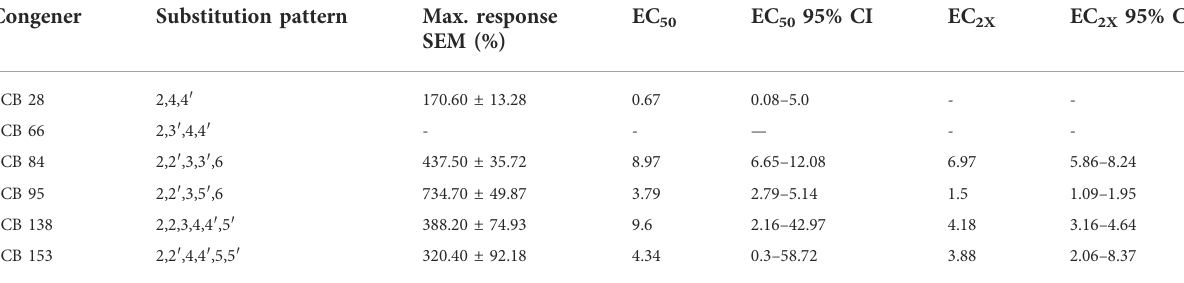
TABLE 1 PCB-induced activation of the RYR paralogs found in zebra fi sh skeletal muscle.